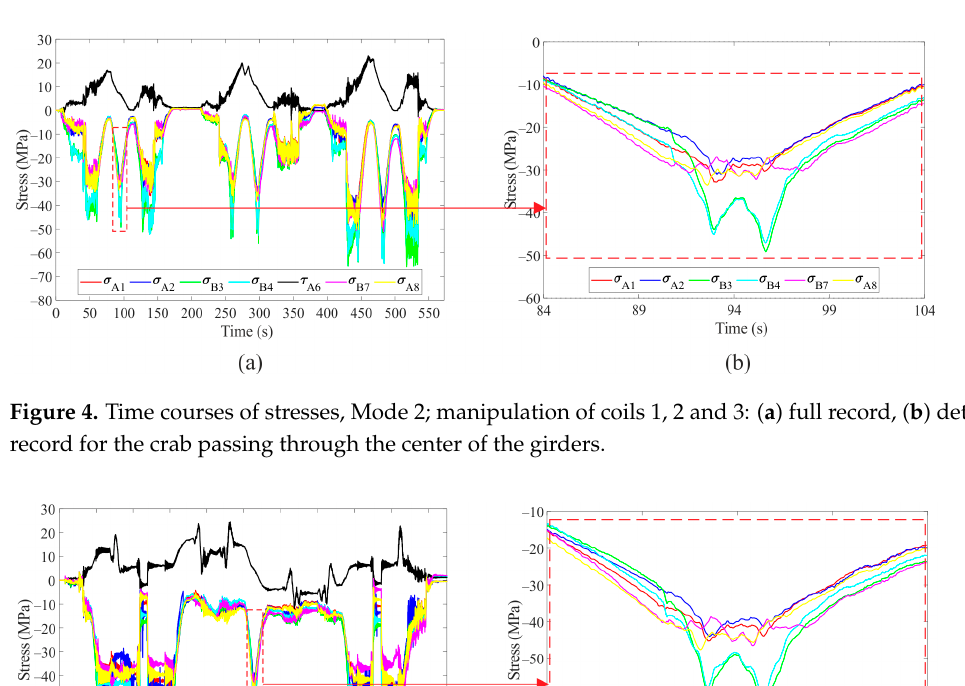
Figure 3. Time courses of stresses, Mode 1; movement of the crab without load: ( a ) full record, ( b ) detail record for the crab passing through the center of the girders.